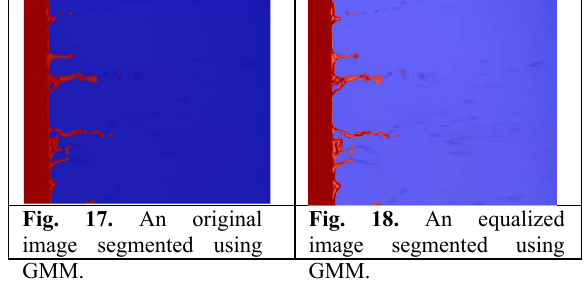
Fig. 13. An original image segmented using active contour.